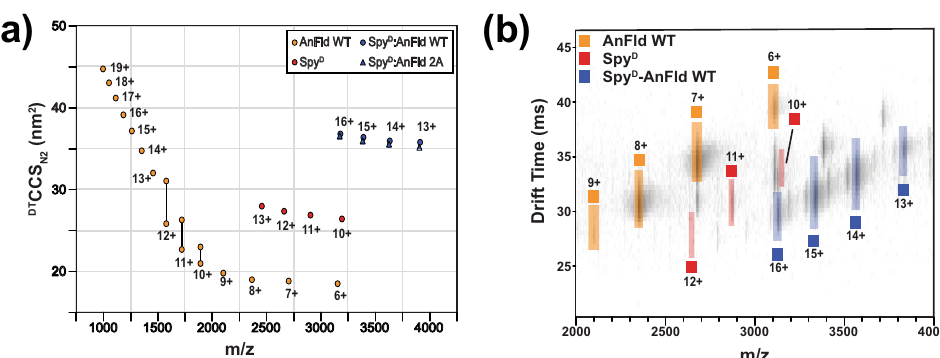
Fig. 4 Native IM-MS to study AnFld and its complex with Spy. a Collision cross-sections of AnFld WT (orange circles), Spy (red circles), Spy:AnFld WT (blue circles) versus m/z. The complex of Spy:AnFld 2A (blue triangles) is also plotted for comparison of the complexes. b Ion mobility mass spectrum of AnFld WT (orange) co-incubated with SpyD (red). Complexes of SpyD:AnFld WT are highlighted